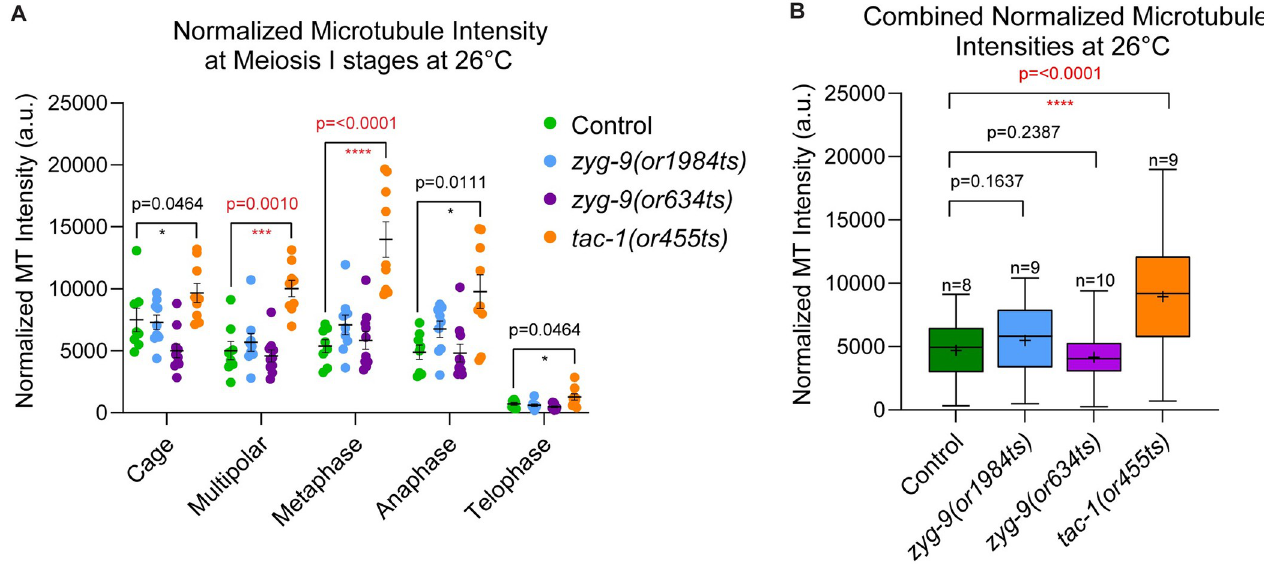
Fig 3. Microtubule levels are elevated throughout meiosis I in tac-1(or455ts) oocytes. (A-B) Normalized microtubule pixel intensity at 26˚C in arbitrary units (see Materials and Methods) for (A) oocyte spindles at each stage of meiosis I, error bars and values are mean ± SEM; and (B) all meiotic stages combined for control and TS mutant oocytes. The boxplots display the datasets, with the median (line) and mean (+) intensity values for control and mutant oocytes; bars are 75% and whiskers are 95% of the observed normalized microtubule intensity values (S3 Data). � , P < 0.05; �� , P < 0.01; ��� , P < 0.001; ���� , P < 0.0001.